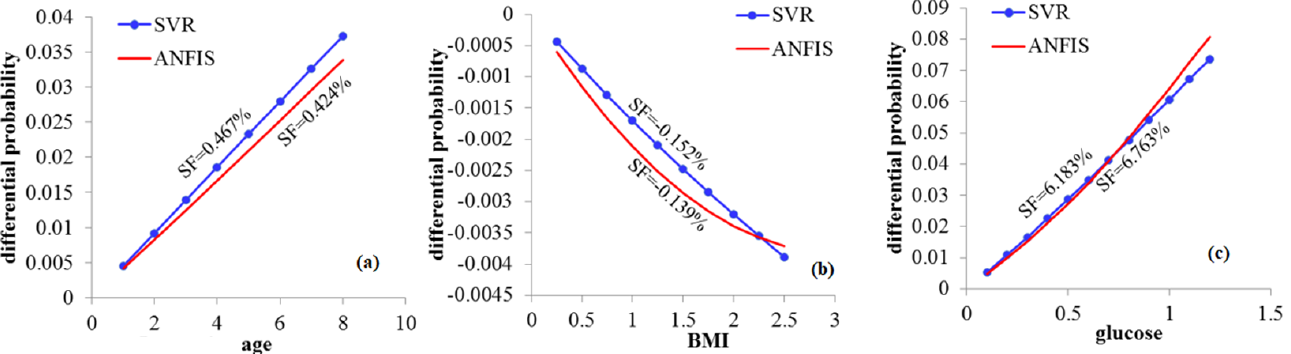
Figure 1. Plots of DFs for age ( a ), BMI ( b ) and glucose ( c ); see abbreviations in Nomenclature.